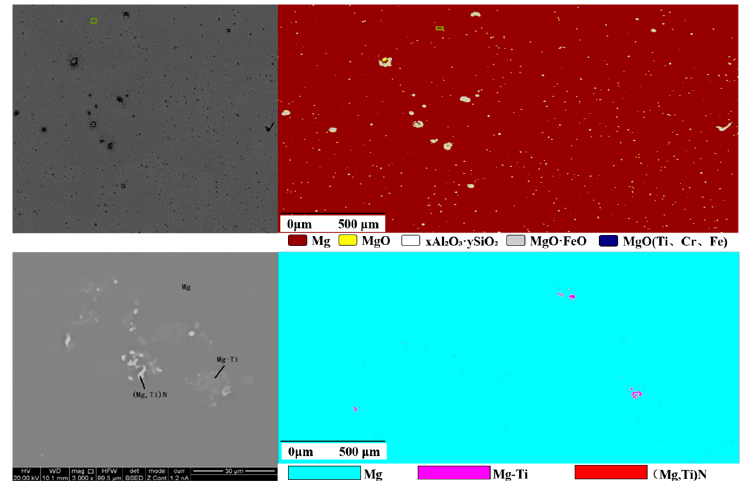
Figure 4. MLA results for the electrolytically produced CM.